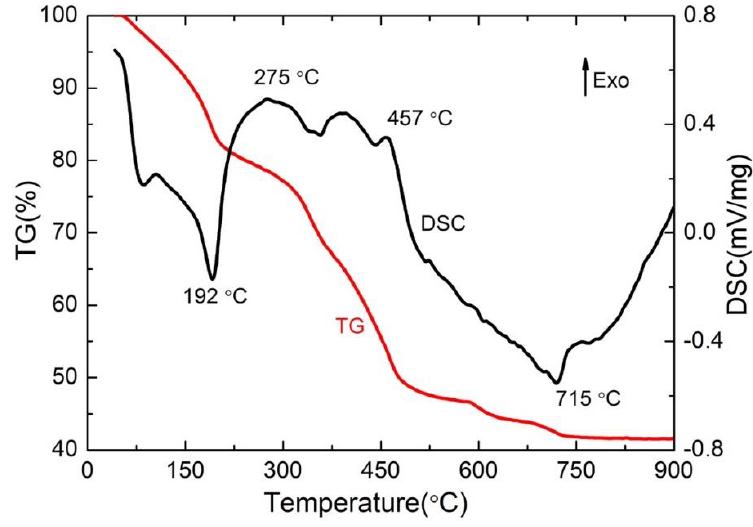
Figure 3. The TG-DSC curve of the precursor.